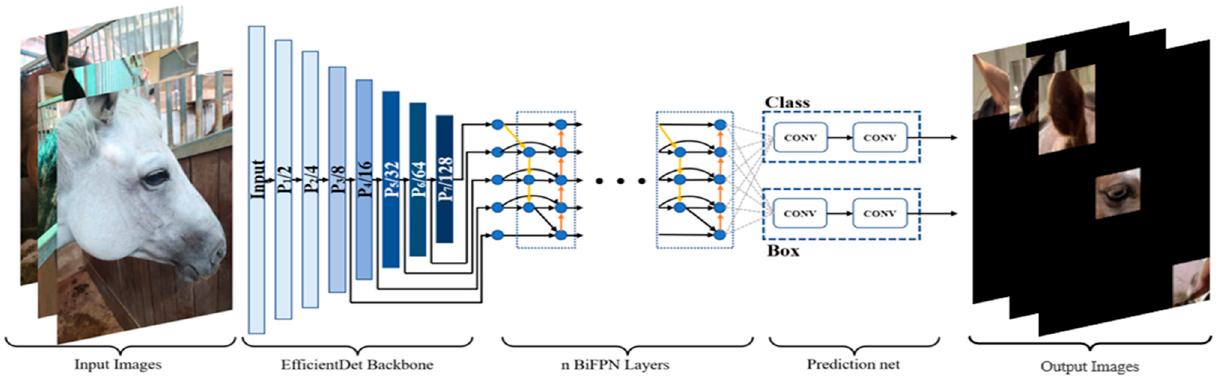
Figure 4. Architecture and performance comparison of EfficientDet. It becomes heavier from D1 to D7; D4 was selected, known as the appropriate level.